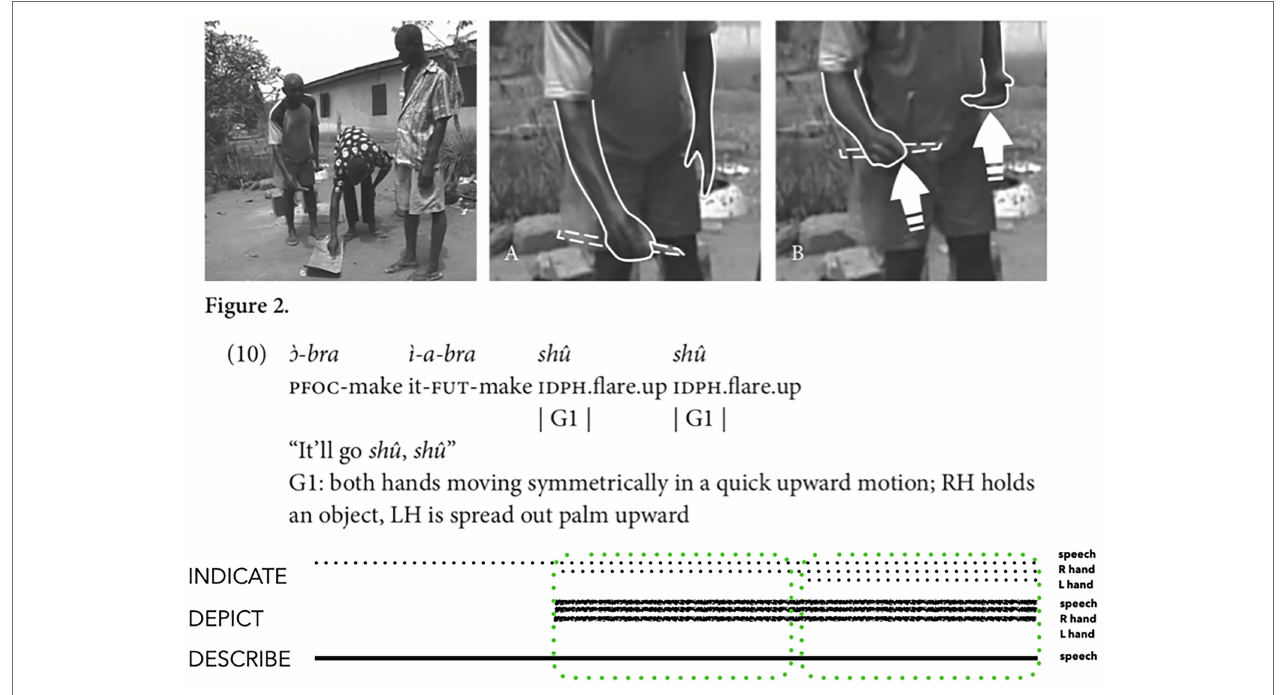
FIGURE 2 | Composite utterance produced by a hearing speaker of Siwu (adapted from Dingemanse, 2013: 158 and reproduced with permission from the author and John Benjamins Publishing Company, Amsterdam/Philadelphia,